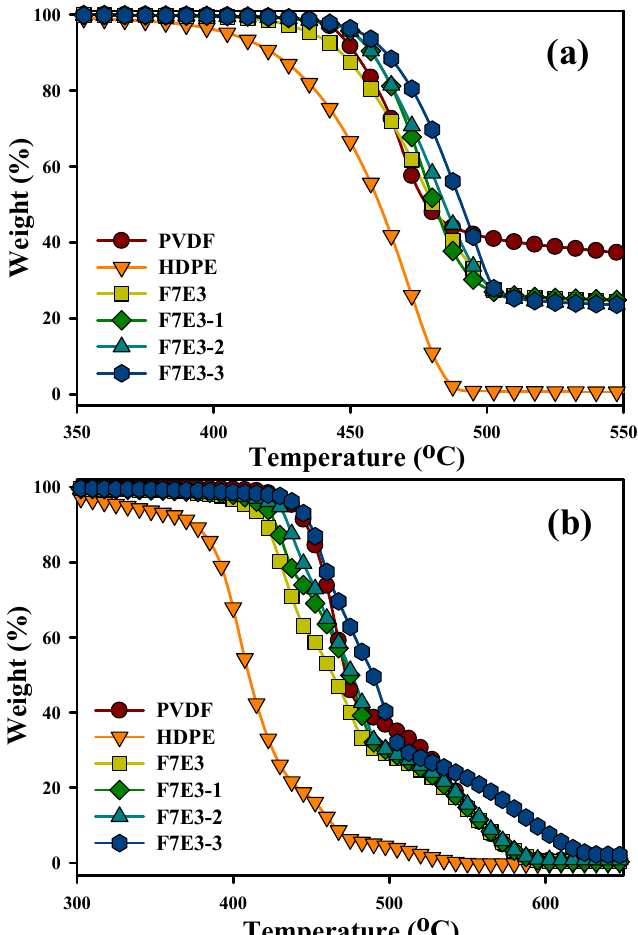
Figure 2. Thermogravimetric analysis (TGA)-scanned curves of selected samples under ( a ) N 2 environment and ( b ) air environment.